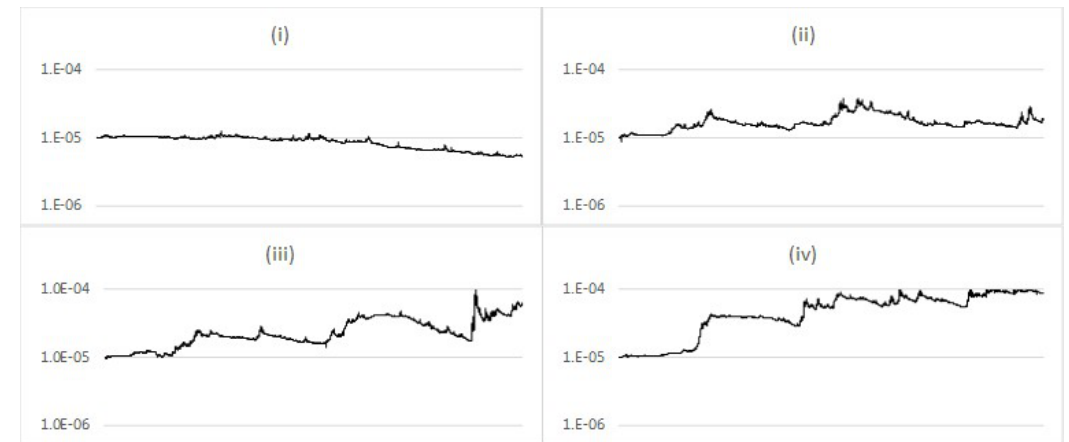
Figure 13. Comparison of average φ (log-scale) for the stochastic volatility model with different values of stochastic volatility ν ( i ) 0.1; ( ii ) 0.2; ( iii ) 0.3; ( iv )